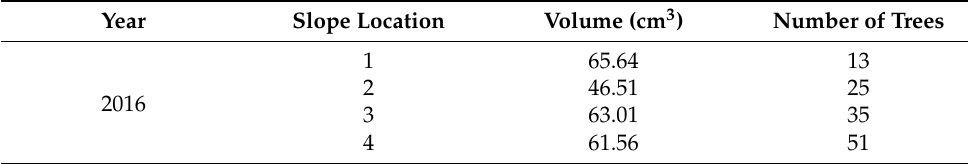
Table 5. FRA tree seedlings volume and number of trees per slope